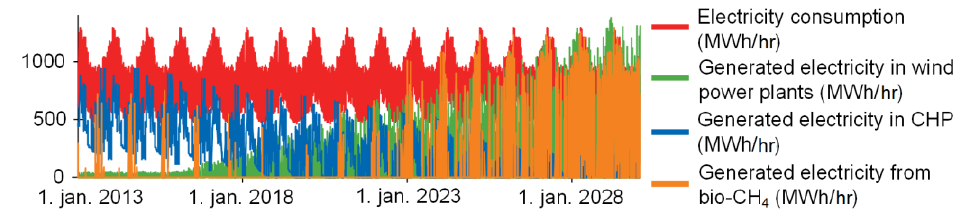
Fig. 9. The total balance of the electricity generated and electricity demand in second scenario.